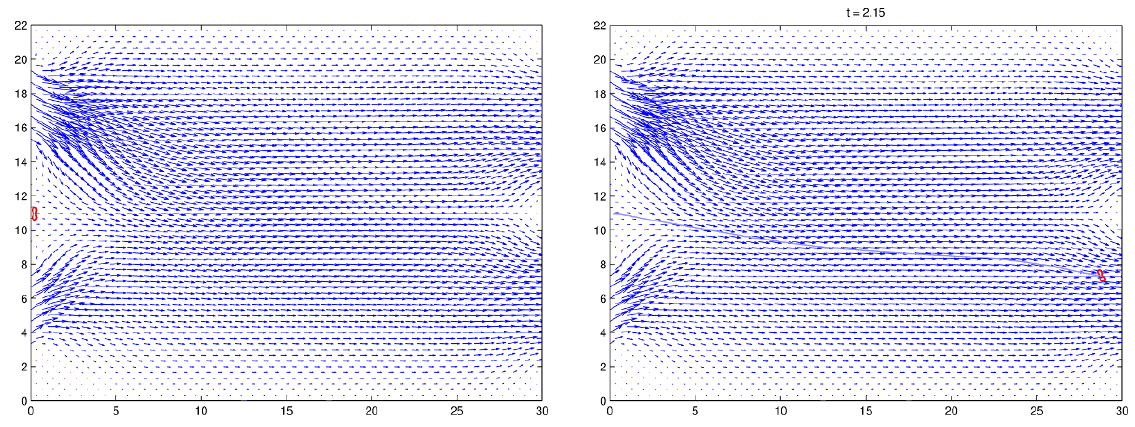
Figure 5. Velocity field and motion of an RBC without SAW actuation: Initial state after injection (left) and state shortly before the RBC leaves the separation channel (right).